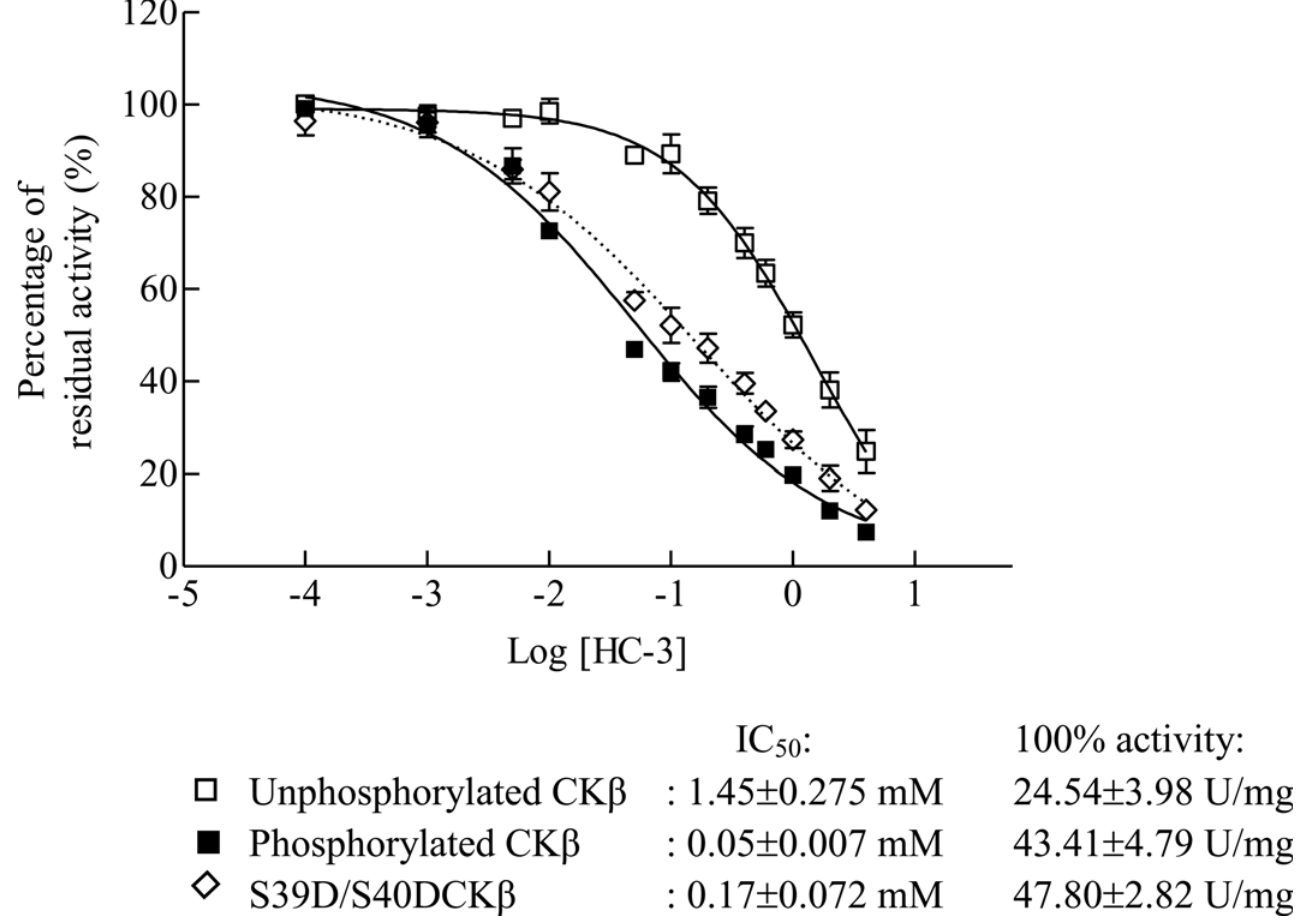
Fig 7. Effect of PKA phosphorylation and phosphorylation mimic mutation of CK β on the sensitivity to HC-3 inhibition. The activities of unphosphorylated, in vitro phosphorylated, and S39D/S40D-mutant CK β were measured by PK-LDH-dependent coupled-enzyme assays as described in the experimental procedures, with 4 mM choline as substrate and the indicated HC-3 inhibitor concentrations. Each bar represents the standard error of the mean (SEM) from three independent